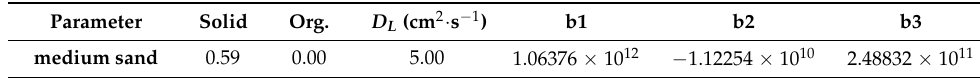
Table 2. Soil thermodynamic parameters .